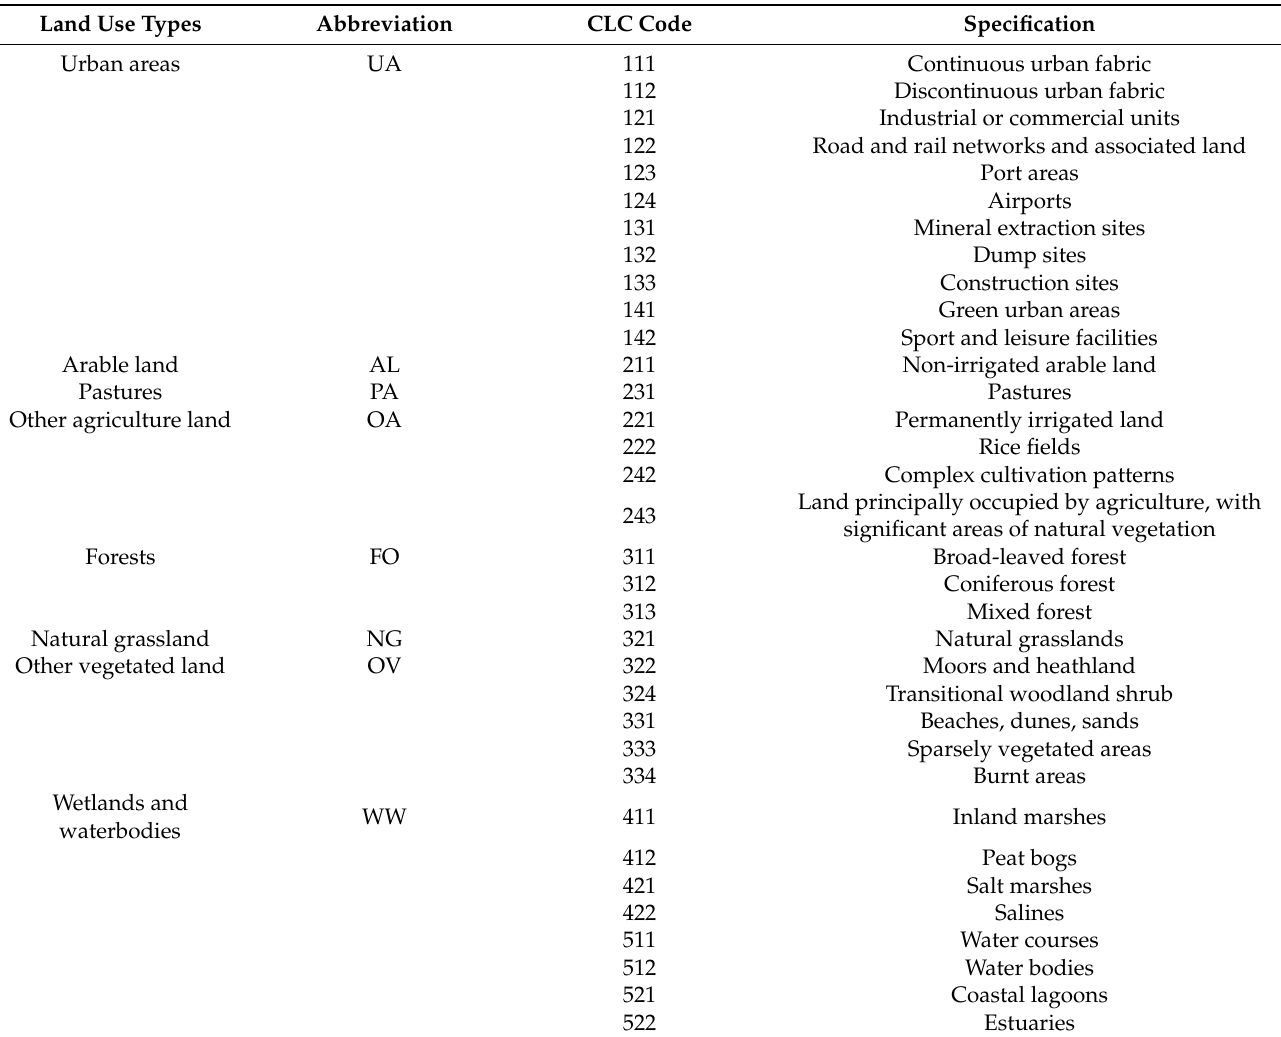
Table 4. Land-use types in the current